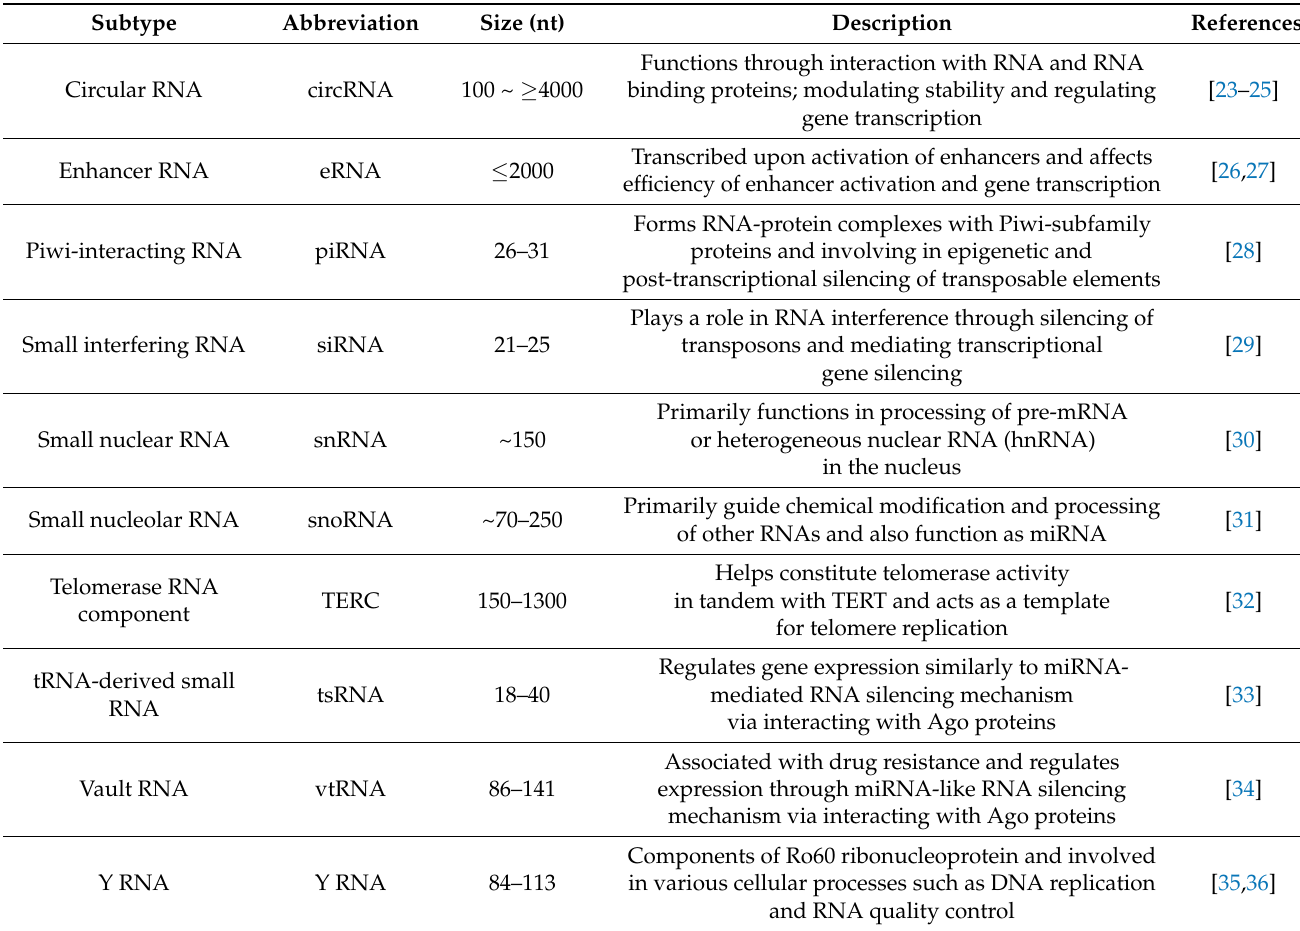
Table 1. Different types of existing noncoding